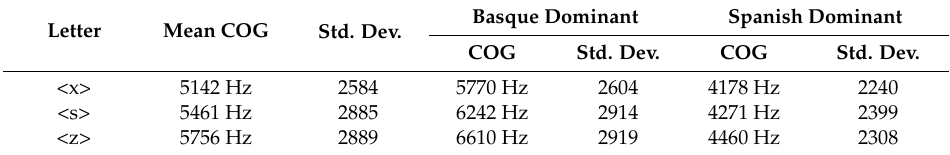
Table 3. Mean Center of Gravity (COG) values in Hz and standard deviations for the three letters in the present study by language dominance and letter.